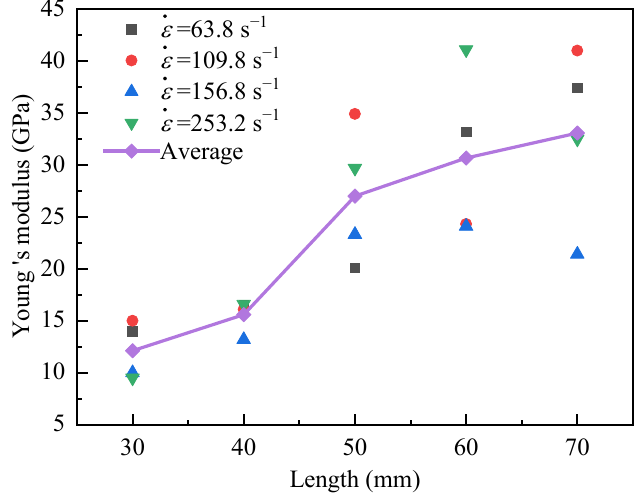
Figure 14. Young’s modulus curve.